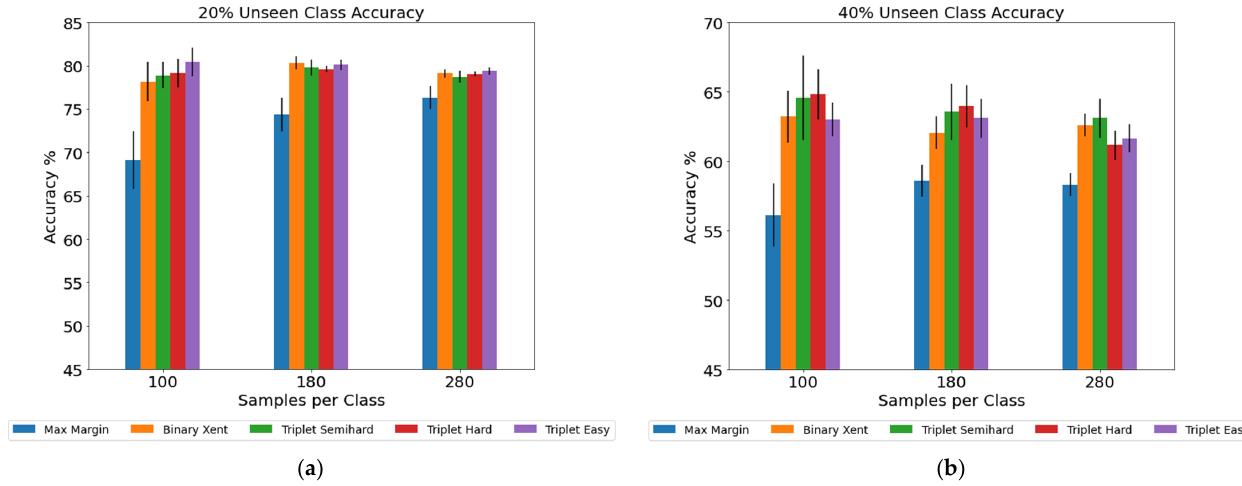
Figure 15. Accuracy of max-margin, binary cross-entropy, and triplet semihard, hard, and hard-soft-margin with test sets containing 20% ( a ) and 40% ( b ) unseen classes.